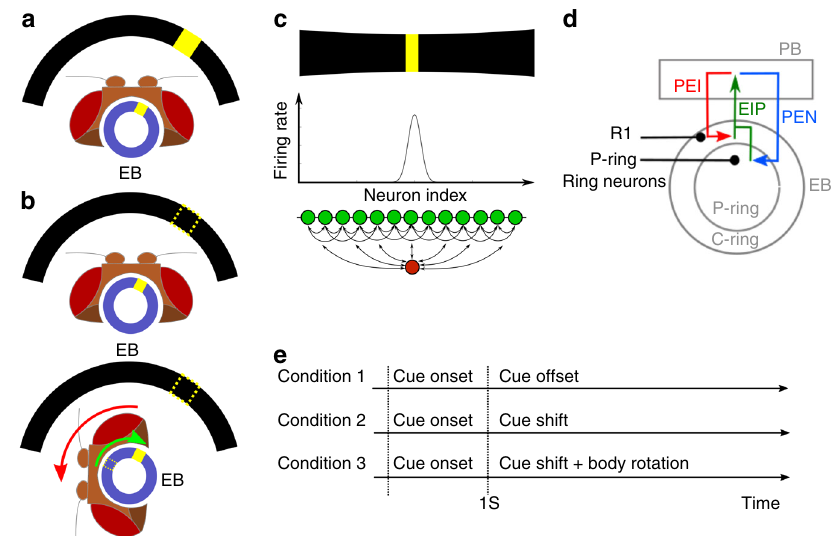
Fig. 1 The maintenance of spatial orientation and the ellipsoid body (EB) circuit in Drosophila . a A schematic of a fl y head and EB ( blue circle ), which can be mapped to 360° of the visual fi eld (partially represented by the black arcs ). When a visual cue (the yellow bar in the visual fi eld) is presented, the EB responds to it with localized activity, or the activity bump ( yellow square in EB). b Top : When a visual cue is removed ( dashed bar ), the activity bump persists, representing the memory regarding the orientation of the visual cue. Bottom : When the fl y changes its orientation in darkness, the activity bump shifts accordingly, indicating the ability to maintain spatial orientation in the dark 10 . c An activity bump, which is localized neural activity ( middle ) in response to a visual stimulus ( top ), is considered as a neural representation of working memory of the task-relevant stimulus if the bump persists after the offset of the stimulus. Theories suggest that the activity bump can be maintained by a network with local recurrent excitation and global feedback inhibition ( bottom ). Green circles : excitatory neurons. Red circle : inhibitor neurons. Arrows : synaptic connections. d The circuit considered in the study consists of three classes of observed neurons (PEI, PEN, and EIP) that connect the EB and protocerebral bridge (PB). EIP neurons project from the EB (both C and P rings) to the PB and form two feedback loops with the PEI and PEN neurons separately. We also consider ring neurons ( black) that innervate the C-ring (R1) or P- ring. e We performed the simulated spatial orientation task under three conditions. For all three conditions, the cue was turned on at t = 0 s and remained for 1 s. In the fi rst condition, the cue was turned off at t = 1 s. In the second condition, the cue remained on but its location (azimuthal angle) began to shift after t = 1 s. In the third condition, the cue was turned off at t = 1 s, after which the fruit fl y body began to rotate